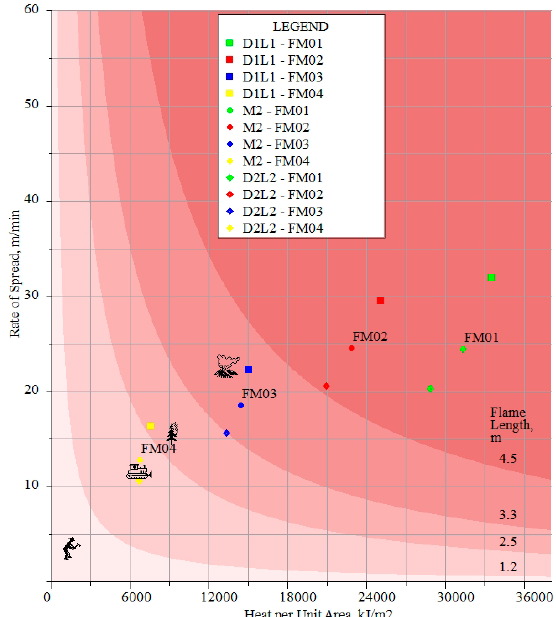
Figure A1. Fire characteristics chart of the simulated fire behavior of the four custom fuel models for conifer forests. Table A3. Fire behavior simulation results using the BehavePlus software for the four custom fuel models for conifer forests. FMS: Fuel Moisture Scenario. Maximum Rate of Fireline Intensity Spread (m/min) Flame Length (m) (kW/m)